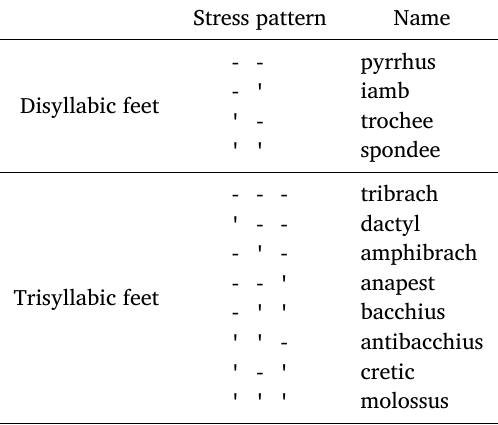
Metrical feet used in English poetry supported by